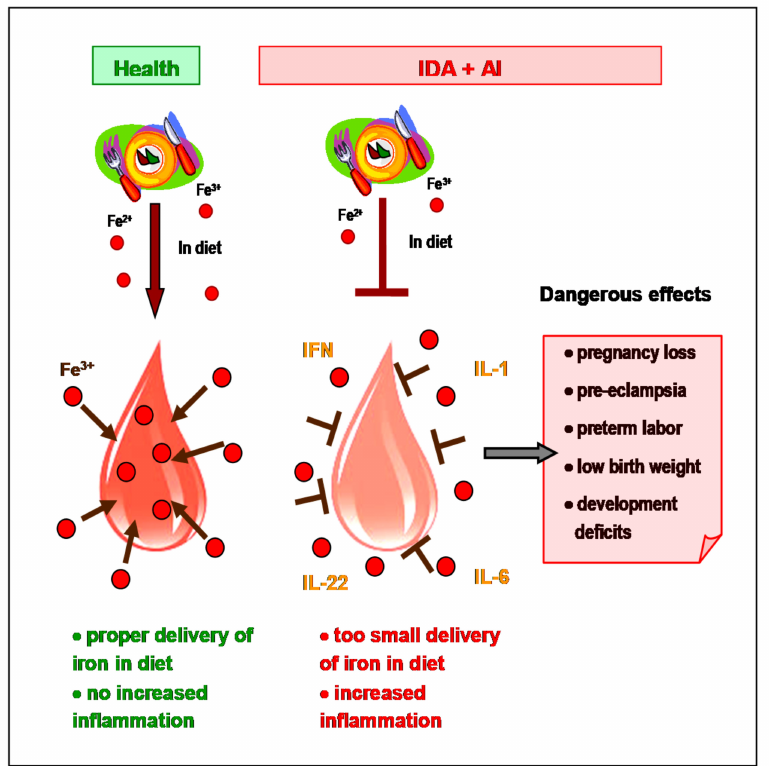
Figure 3. Dangerous consequences of coexisting iron deficiency anemia (IDA) and anemia of in- flammation (AI) during pregnancy. Inadequate delivery of iron from diet is responsible for “true” deficit (IDA), which is aggravated by simultaneous inflammation responsible for “functional” defi- ciency (AI). IDA and AI are dangerous to mother and her offspring. Fe—iron ions, IL—interleukin,